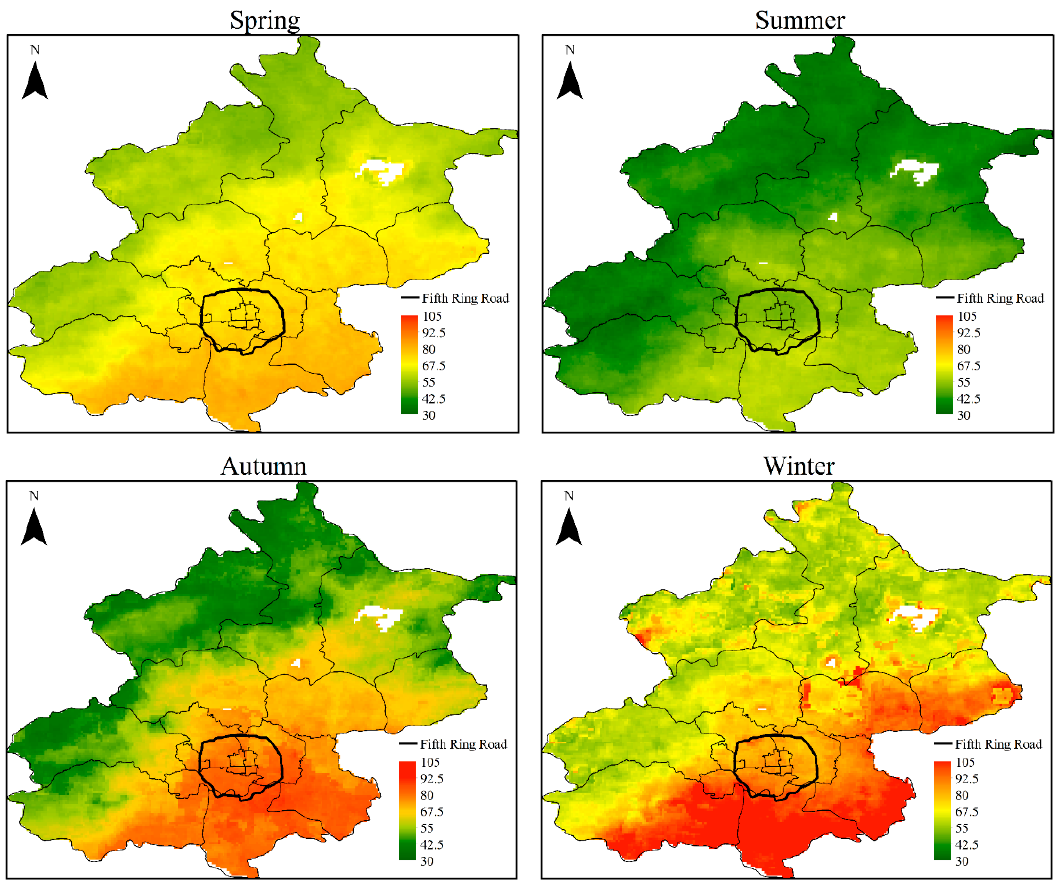
Figure 10. Seasonal mean PM 2.5 concentrations ( µ g/m 3 ) calculated from daily PM 2.5 estimations during 2013–2017.